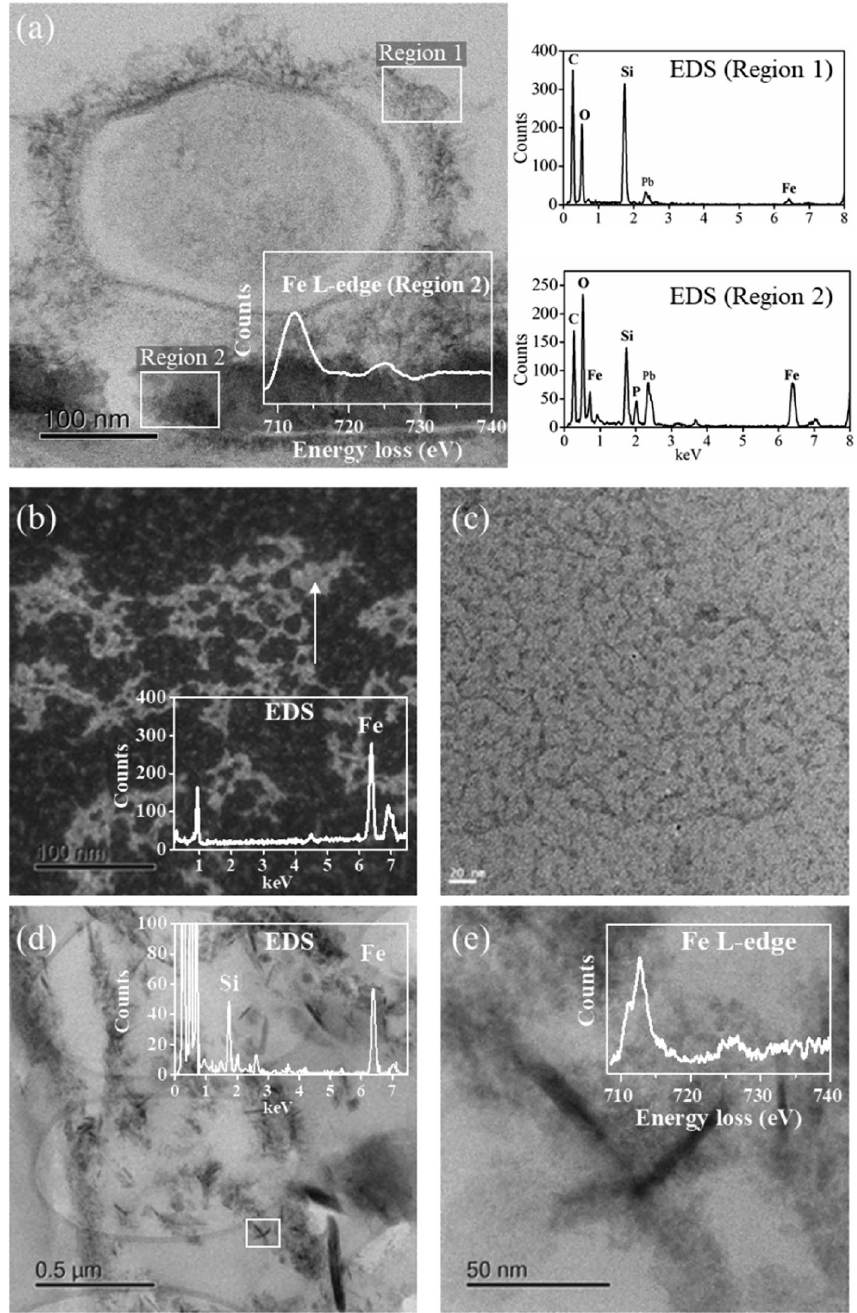
Figure 5. STEM analyses of a transverse section of a rice root exposed to enhanced biochar. ( a ) Bright field (BF) image of a microbe attached to the root epidermis. The two rectangular regions of interest are where EDS/EELS analyses were performed. The EDS spectra show a concentration of Si with small amounts of Fe at the surface layer of the microbe (Region 1), and significant concentrations of Si, Fe, and P at the microbe- root interface (Region 2). The Fe L-edge EEL spectrum of region 2 is shown inset in ( a ) where the edge shape is typical of Fe 3 O 4 . ( b ) High-angle annular dark field (HAADF) image of the intracellular agglomerate of the root. The EDS spectrum from the region arrowed is shown inset where a high concentration of Fe is detected. ( c ) A magnified BF image of the agglomerate showing matrices containing an iron-rich core with a diameter of around 5 nm. ( d ) BF image of an intracellular cluster of particles showing high concentrations of Si and Fe detected by EDS analysis. ( e ) Detailed view of the boxed region in ( d ) showing the needle-like particles, with the inset showing the Fe L-edge EEL spectrum typical for iron minerals with mixed oxidation states